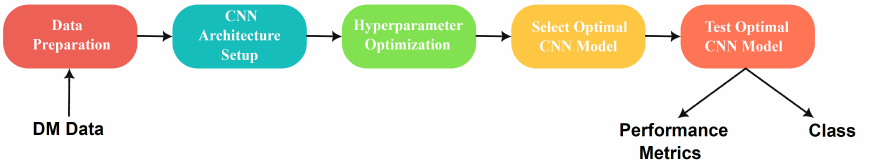
Figure 2. The framework of the proposed deep learning CNN for the detection of DM in retinographs.